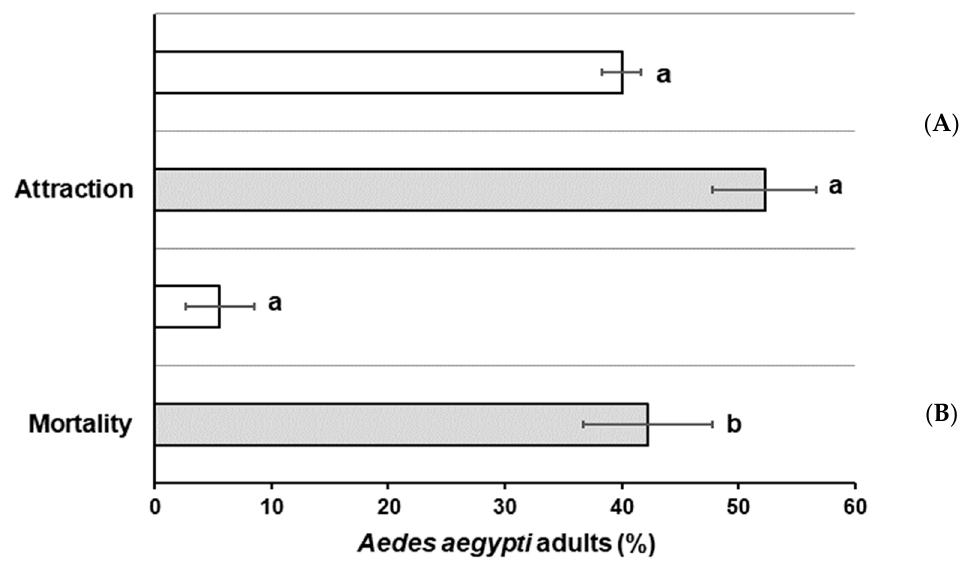
Figure 2. Percentage of Ae. aegypti adults attracted and killed by microgranular formulation (MGFs) with ( gray bar) or without ( white bar) Beauveria bassiana as active ingredient (AI). ( A ) Attraction percentage and ( B ) mortality percentage after exposure to BBPTG4 on MGF . Data represent mean + SEM of triplicate determinations from three independent experiments. Same letter on each column indicates that treatments are not significantly different (Student t test; p ˂ 0.05).